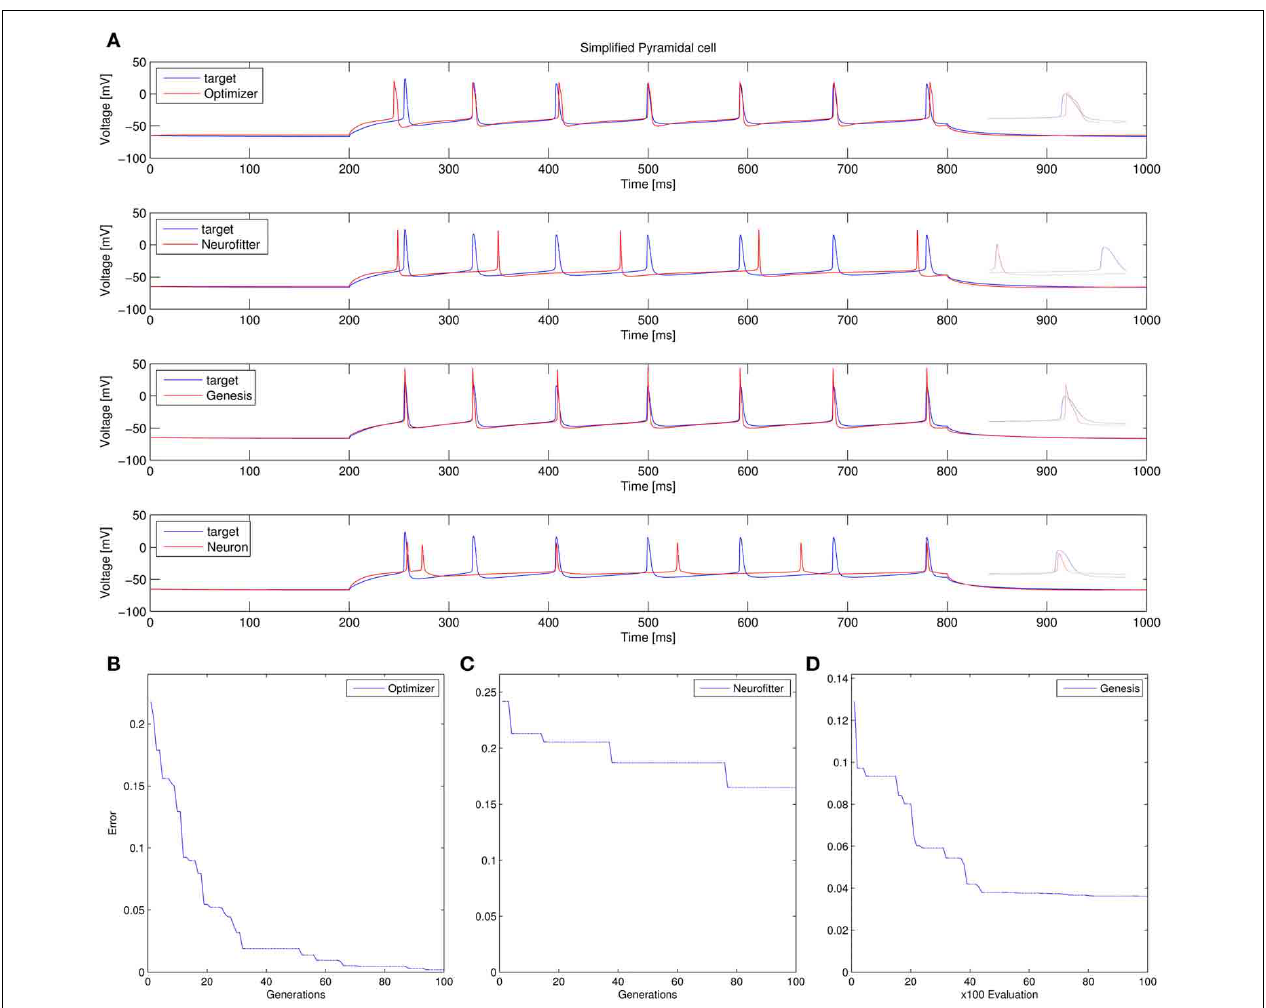
FIGURE 11 | Comparison of the performance of the four model fitting tools on Use case 3 (fitting voltage traces from a detailed compartmental model). Insets allow a better visual comparison of spike